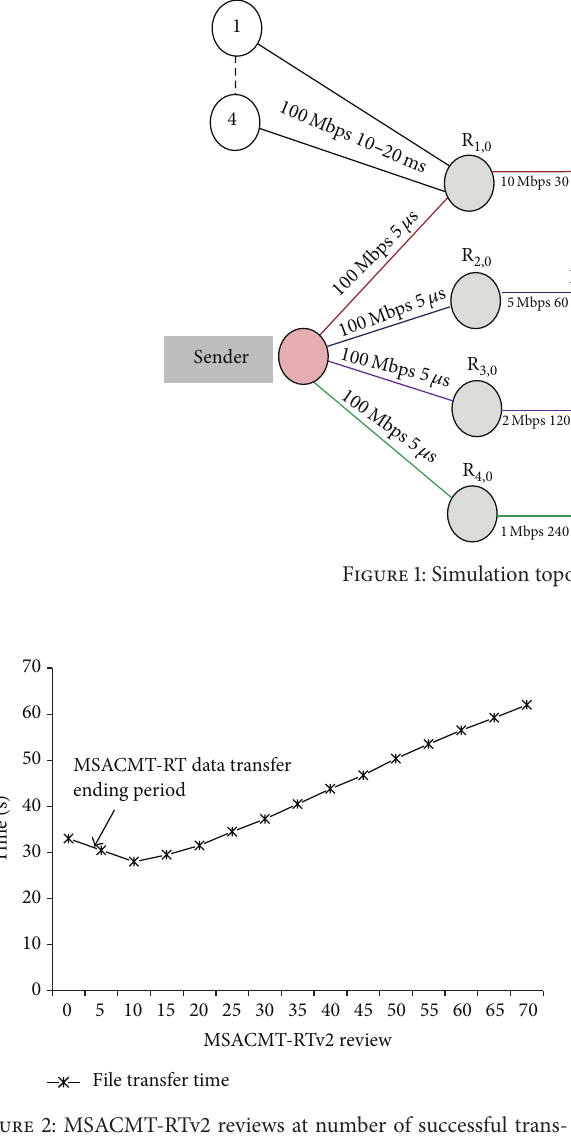
Figure 2: MSACMT-RTv2 reviews at number of successful trans-